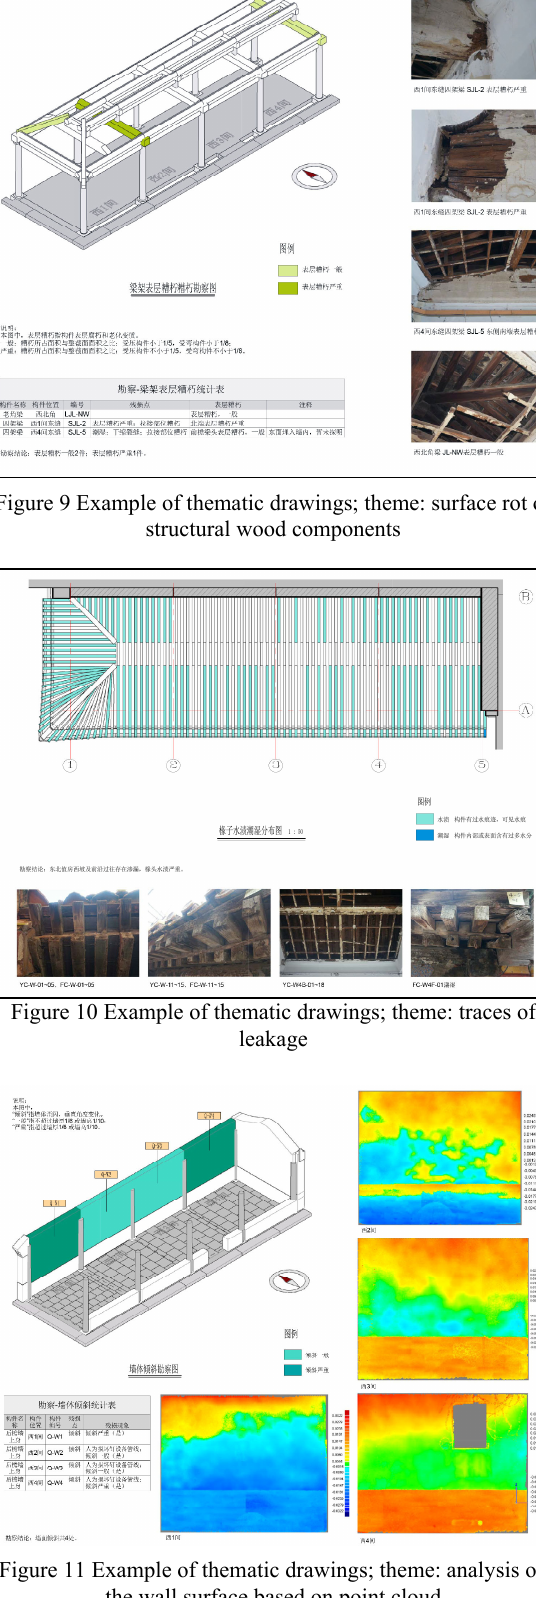
Figure 11 Example of thematic drawings; theme: analysis on the wall surface based on point cloud